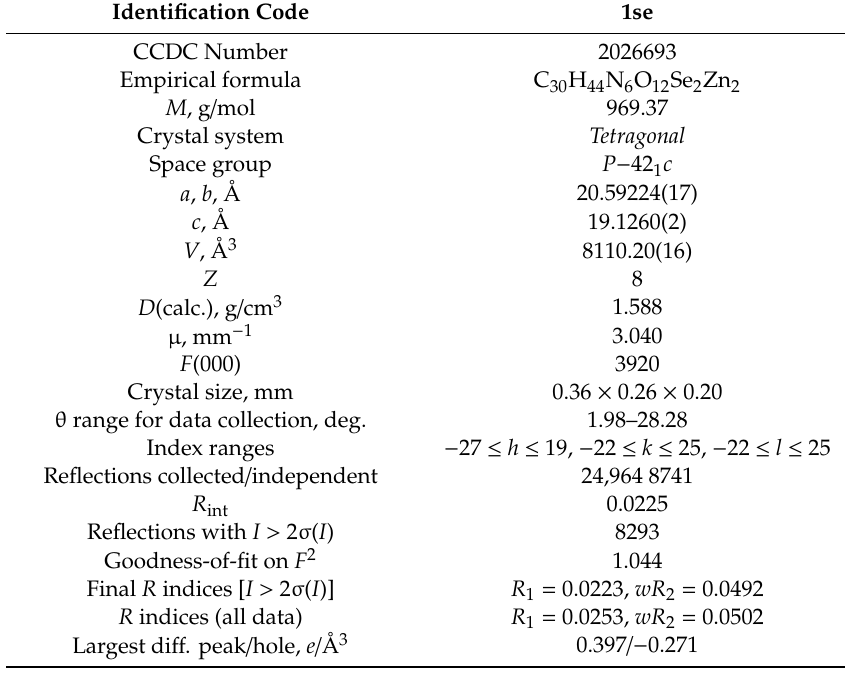
Table A1. Crystal data and structure refinement for 1se